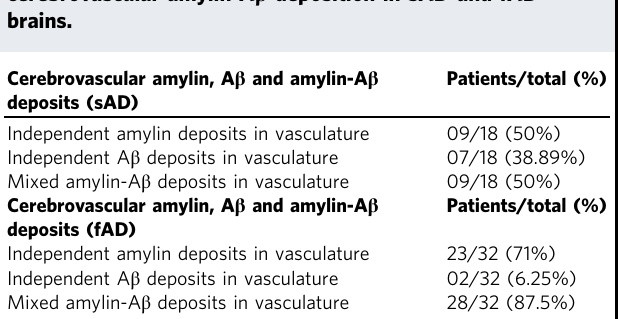
Independent amylin deposits in